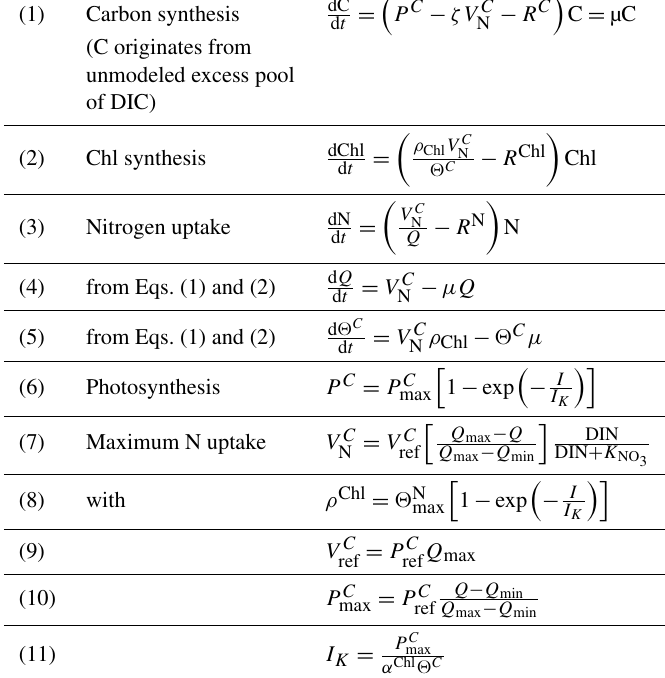
Table A6. Model equations from G98 (Geider et al., 1998) corrected for typographical errors by Ross and Geider (2009) with extensions. DIC stands for dissolved inorganic